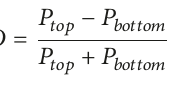
Figure 9: The DNBR distribution along the assembly (zoom